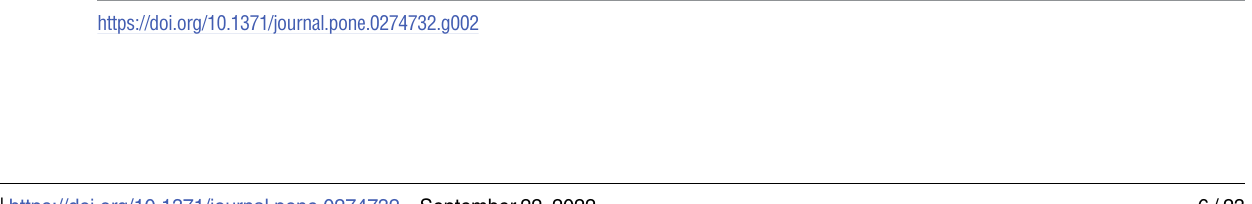
PLOS ONE | https://doi.org/10.1371/journal.pone.0274732 September 22,